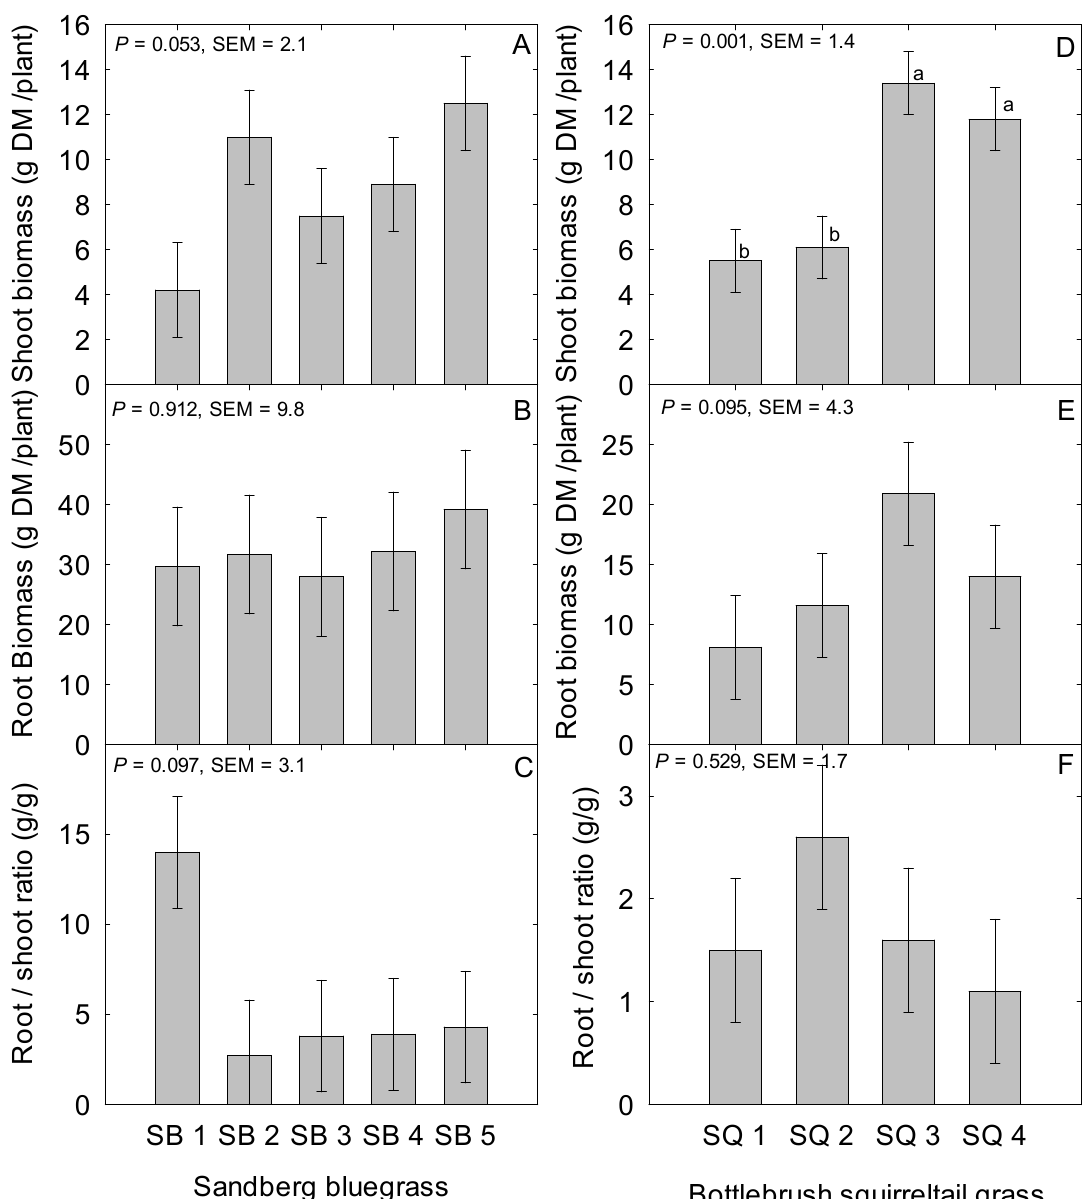
Figure 1. Mean shoot biomass dry matter (DM) grams per plant ( A , D ), root biomass DM grams per plant ( B , E ), root-to-shoot (gram root per gram shoot biomass DM) biomass ratio ( C , F ) of Sandberg bluegrass and Bottlebrush squirreltail populations evaluated under greenhouse conditions during 2015 to 2016 at the University of Nevada, Reno, USA. SB 1; Button Point (LP), SB 2; Panther Valley (LP), SB 3; Winnemucca Mountain (LP), SB 4; Hanford (CV), SB 5; Mountain Home (CV), and Bottlebrush squirreltail, SQ 1; George St. Sonoma (LP), SQ 2; Grass Valley (LP), SQ 3; Toe Jam Creek (CV), and SQ 4; Vale (CV). LP; local population, and CV; cultivar. Bars with same lowercase letters are not different ( P > 0.05).